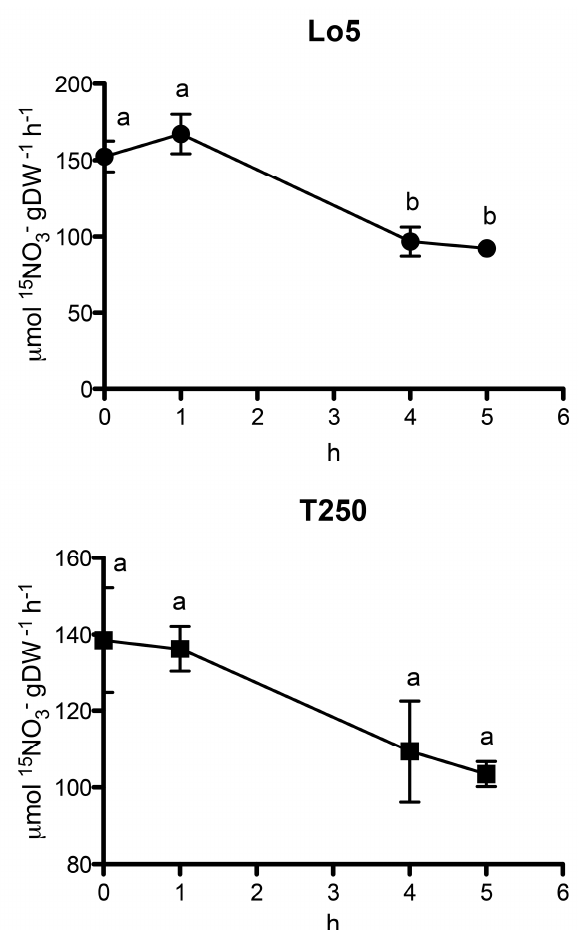
Figure 5. 15 NO 3 − uptake rate during the growth in N ‐ starvation (200 μ M 15 NO 3 − ; mean ± S.E. of three biological replicates). ANOVA test was performed using GraphPad Prism ® ( n = 3, p < 0.01; Tukey method, 95% confidence interval).